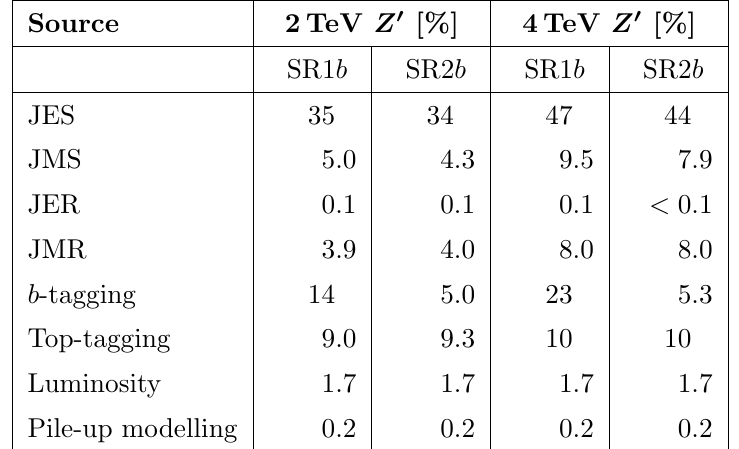
Table 2. Summary of the post-(cid:12)t impact of systematic uncertainties on the expected numbers of Z 0 signal events (expressed as percentage deviations from the nominal predictions) for masses of TC2 2 and 4 TeV in each of the signal regions. The largest absolute value due to the (cid:6) 1 (cid:27) variations is shown for each uncertainty source. The components of top-tagging uncertainties associated with the JES uncertainties are included in the numbers at the row labeled